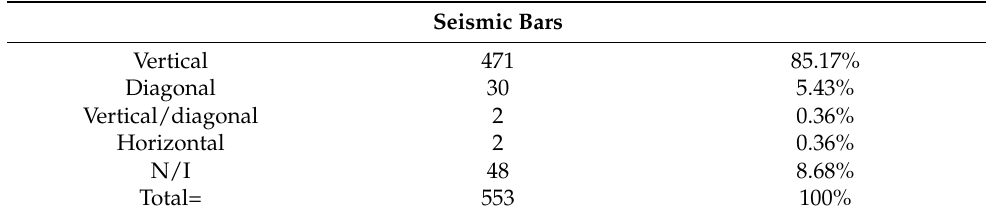
Table 3. Types of anti-seismic bars in Chilean